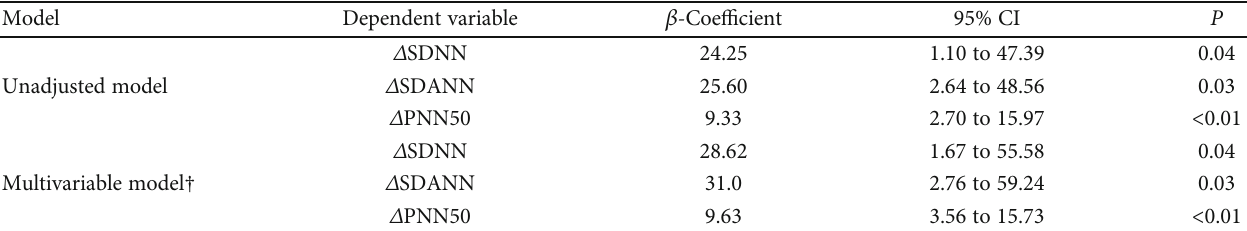
Table 3: Linear regression analyses for the association between metformin add-on treatment and changes in HRV indexes in youth with type 1